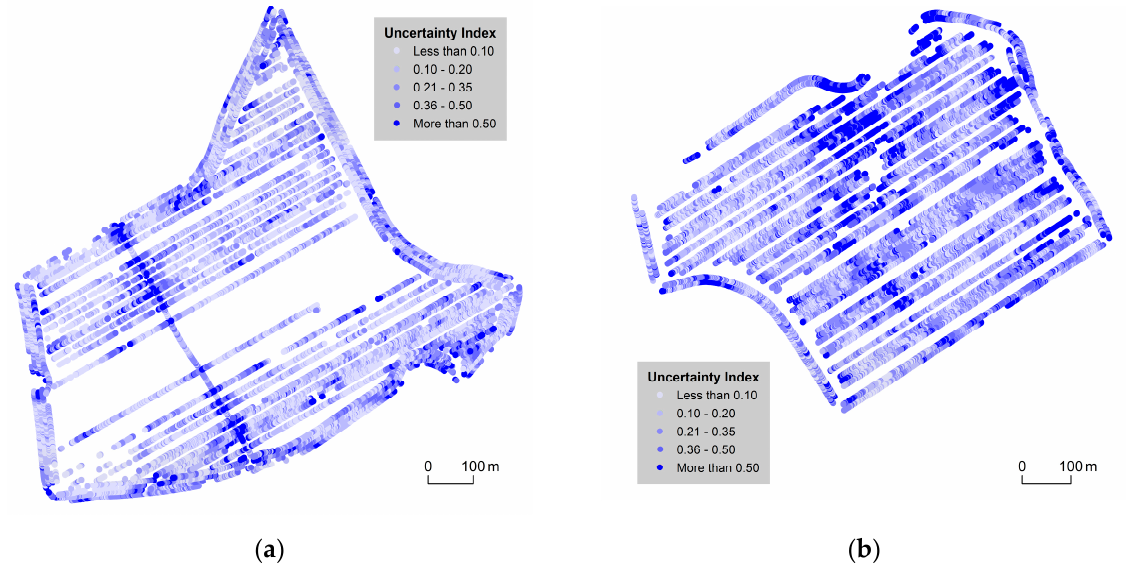
Figure 9. Saturation applied to quantitative data on uncertainty for P ř ední Prost ř ední ( a ) and Pivovárka ( b ).